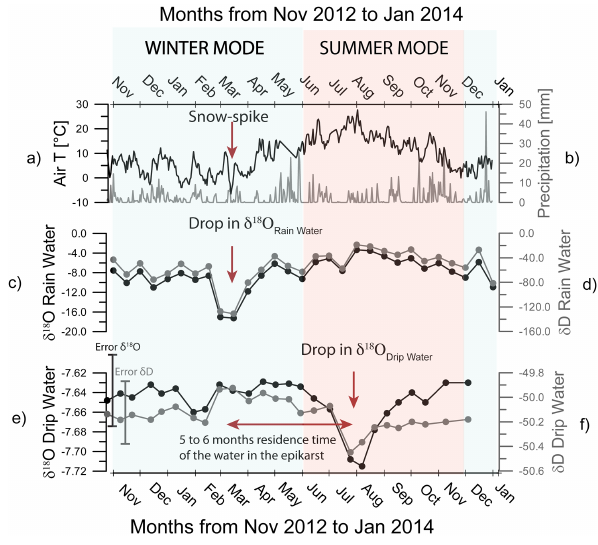
Figure 3. Precipitation (a) and air temperatures (b) are measured at the Han-sur-Lesse station of the Royal Meteorological Institute. The δ 18 O and δ D of the rainwater (c and d) and the δ 18 O and δ D of the drip water (e and f) are all reported in per mill VSMOW. At the end of March a cold temperature peak and prolonged snowfall cause the rainwater δ 18 O to display a sharp drop. This negative spike in the 18 O rain water in March can be found back in the 18 O drip water in August, indicating that at least part of the infiltrating water reaches the cave 5 to 6 months